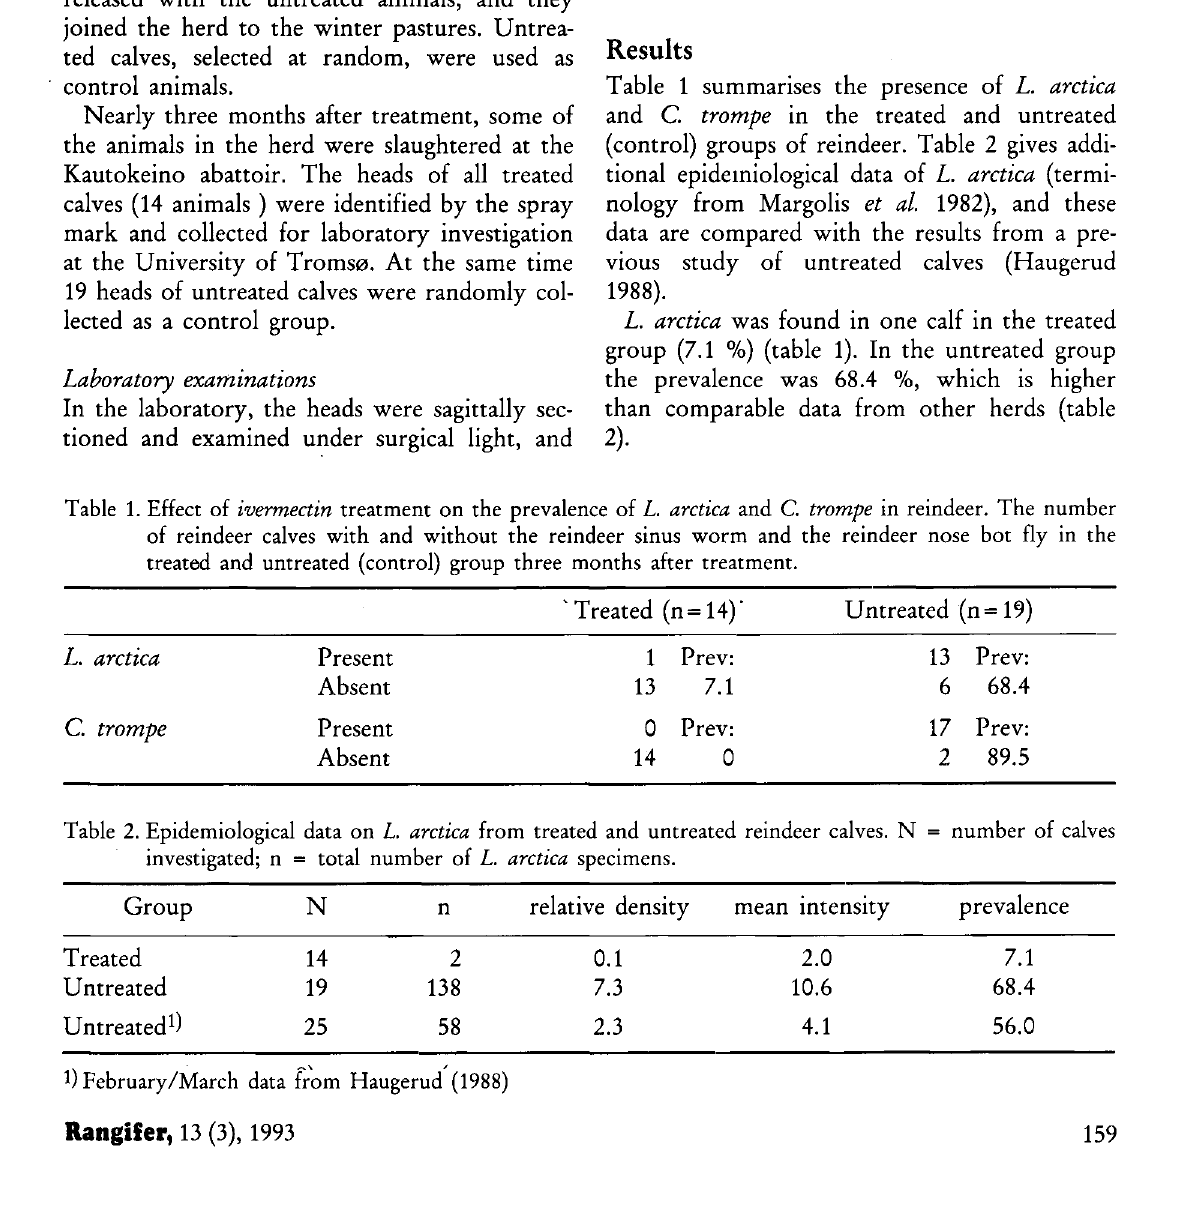
Table 2. Epidemiological data on L. arctica from treated and untreated reindeer calves. N = number of calves investigated; n = total number of L. arctica